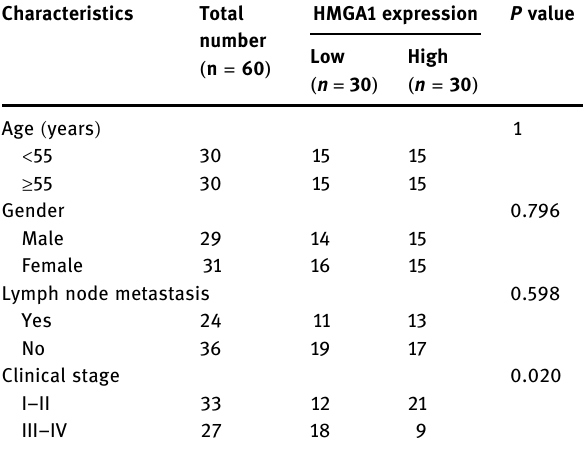
pathological features of ESCC patients